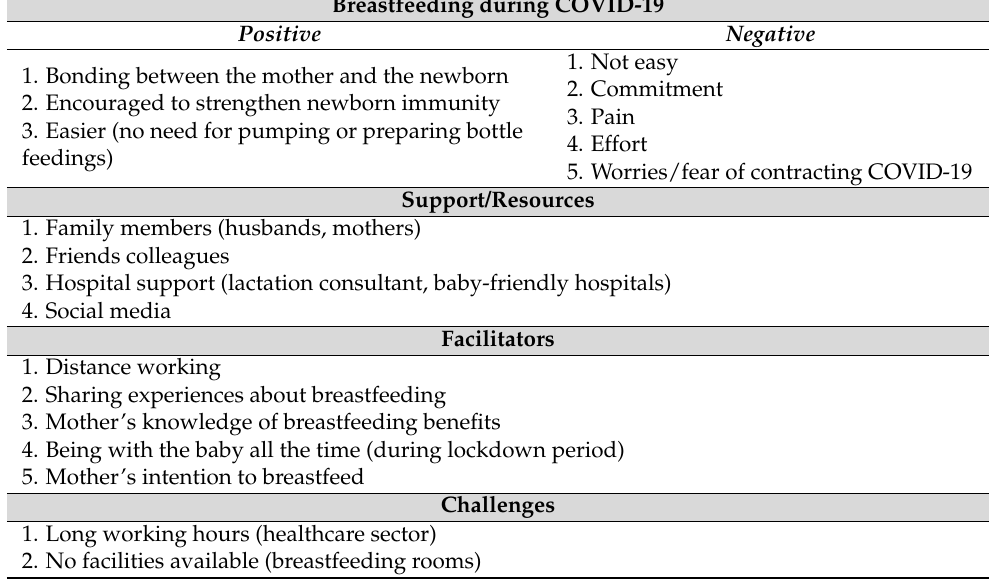
Table 2. Findings on breastfeeding themes during